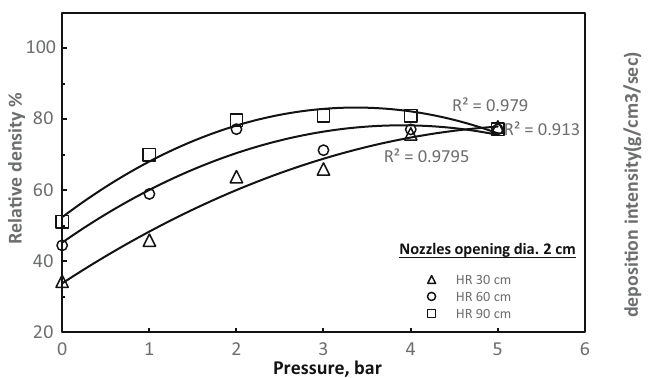
Figure 9: Variation of DI, TAP, and HF for nozzle size of